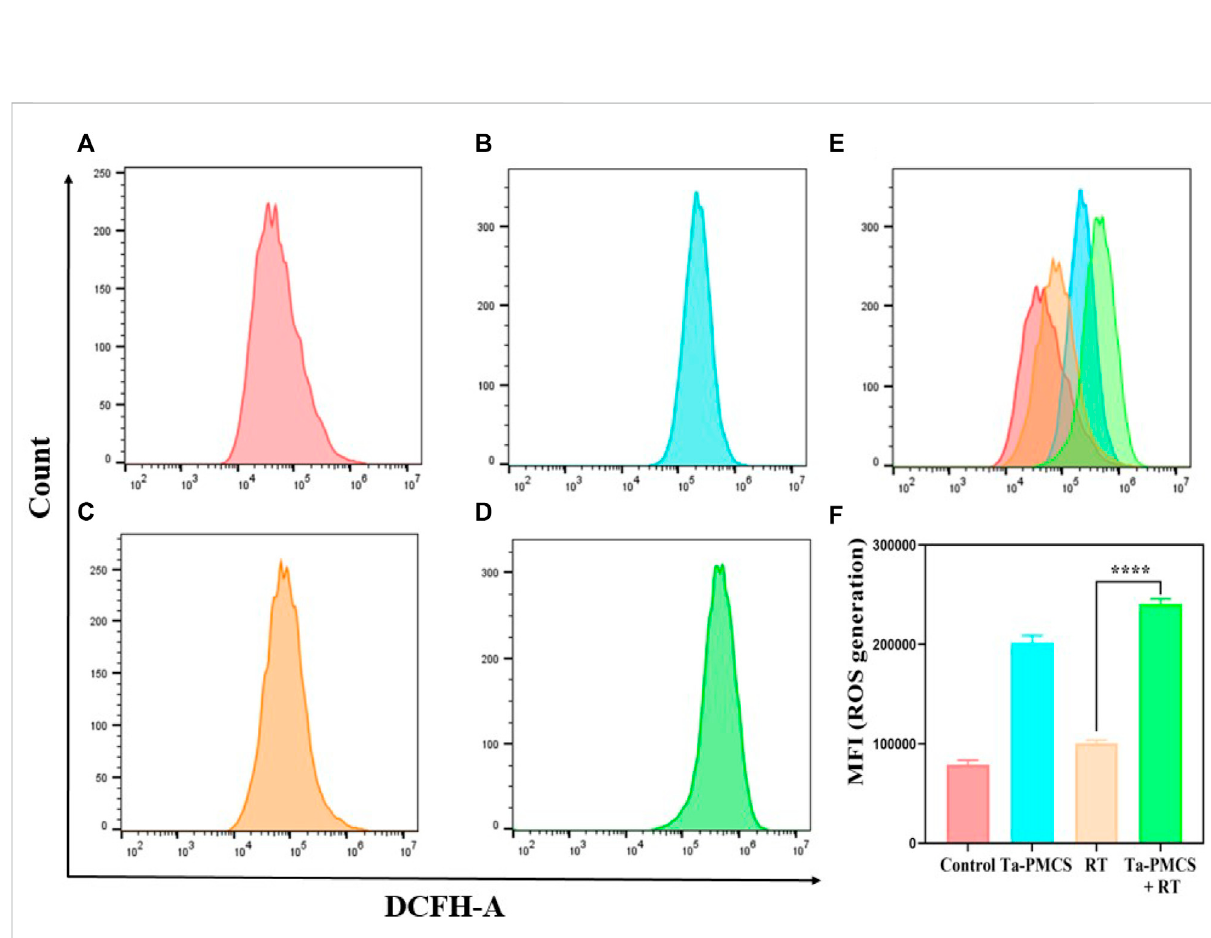
ROS levels were measured by fl ow cytometry after treat with different treatments. (A) Control; (B) Ta-PMSC; (C) RT; (D) Ta-PMSC + RT; (E) merged imaged of (A) , (B) , (C) and (D) . (F) Mean fl uorescence intensity of ROS generation. * p < 0.05, ** p < 0.01, *** p <